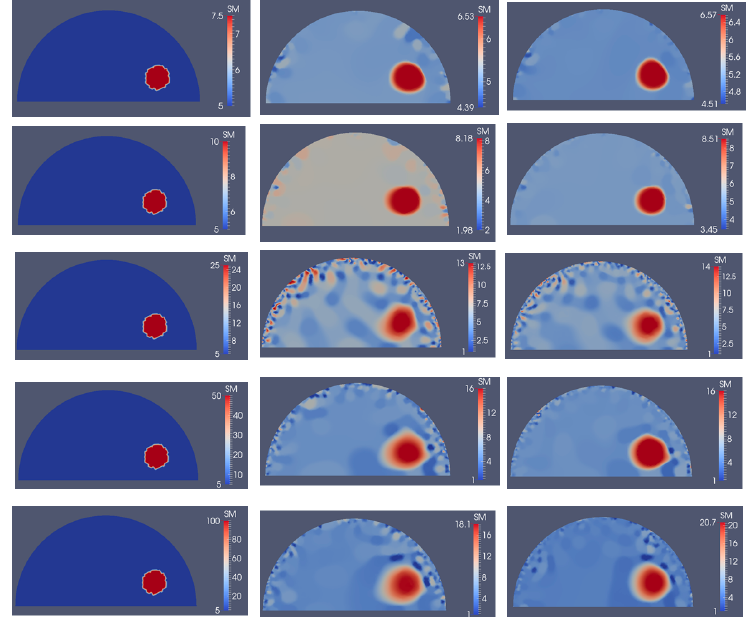
Figure 15. Problem domain with target shear modulus distribution is defined in the first column with varying shear modulus values in the inclusion from 7.5 kPa (top row) to 100 kPa (bottom row) to test the feasibility range of stiffness detection. Column 2 and column 3 represent the shear modulus reconstructions with 5 and 10 boundary displacement data sets, respectively, using 1% noise.